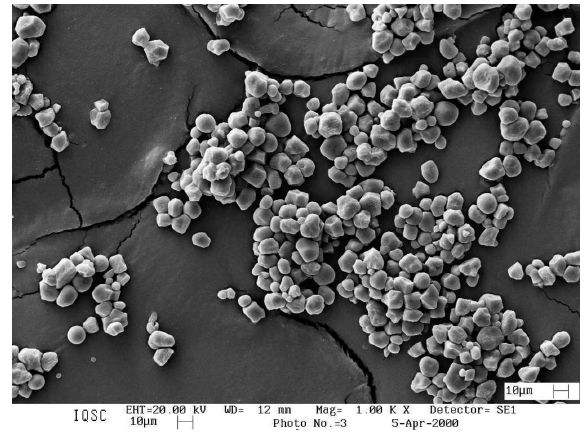
Figure 7. SEM micrograph of amylopectin-rich stanch grains deposited on carbon films (1000x).